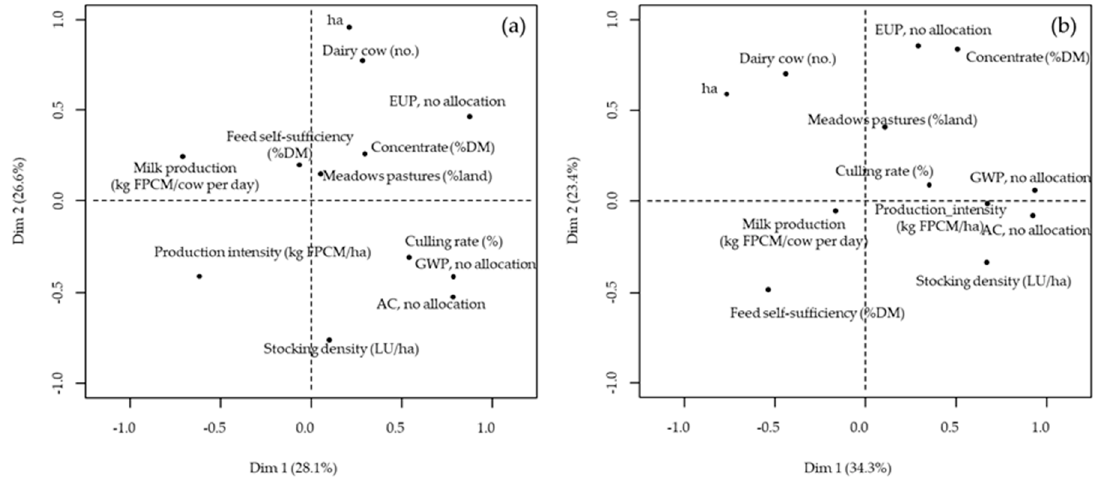
Figure 3. Principal component analysis of farm characteristics and Global Warming Potential (GWP), Acidification potential (AC) and Eutrophication potential (EUP) expressed as CO 2 eq per kg of Fat Protein Corrected Milk (FPCM) ( a ) or as CO 2 eq per m 2 of Utilizable Agricultural Land ( b ). No allocation method was